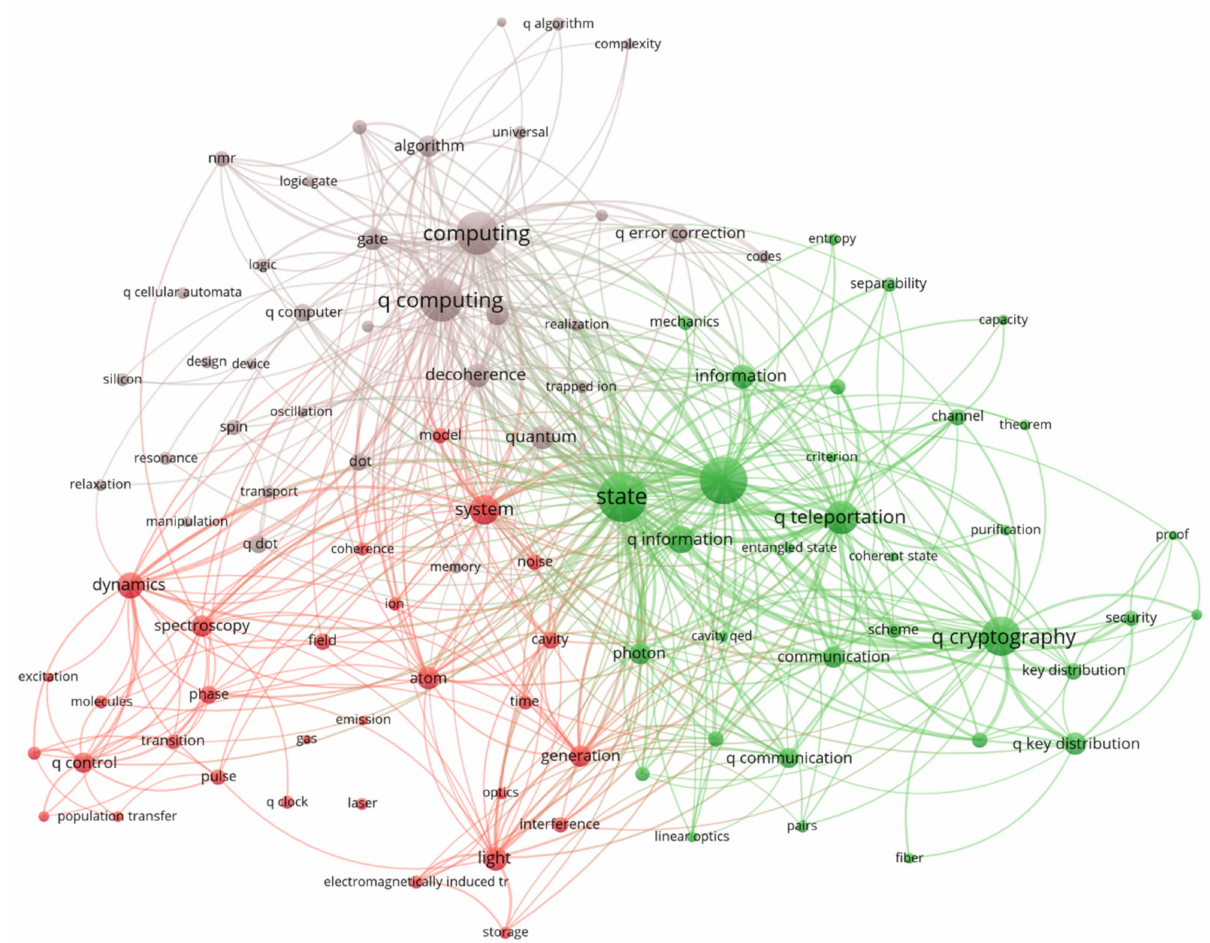
Figure 7. Co-occurrence map of the top 98 keywords (author keywords and keywords plus from 2000 to 2011) with three topical clusters, using the VOSviewer parameters resolution = 1.0 and minimal cluster size = 5. The unnamed big green node belongs to the keyword quantum entanglement. For better readability, in compound keywords the term quantum is abbreviated to q. Readers interested in an in-depth analysis of our publication set can use VOSviewer interactively and zoom in on the clusters. An online version is provided at https://s.gwdg.de/DvXJnY (accessed on 1 August 2021) (cluster colors probably